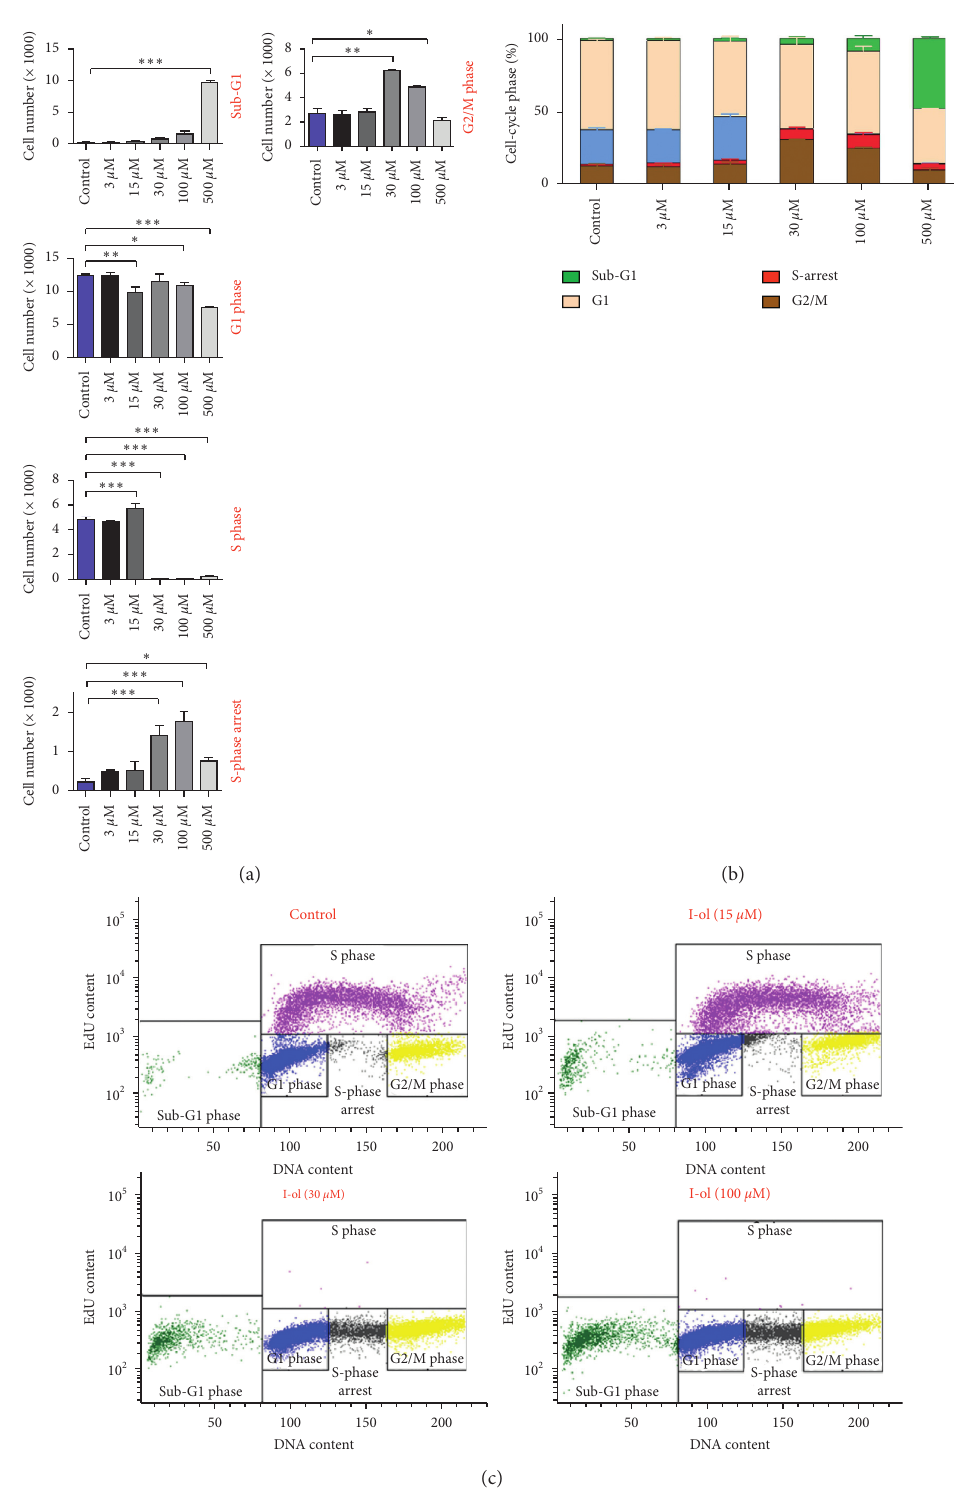
Figure 3: Regulation of cell-cycle progression. (a) Representation of each cell-cycle phase with increasing I-ol concentrations. A phase shift was observed at an I-ol concentration of 30 μ M. Specifically, we observed disappearance of cells in the S phase, a significant increase of S- phase arrest, and a large increase in the percentage of cells in G2/M phase and sub-G1 phase at the highest concentration. (b) Summary of the percentages of individual cells in each phase. (c) Representative scatter chart, where the y -axis represents the EdU-specific fluorescence on a logarithmic scale and the x -axis represents the cell cycle-specific fluorescence on a linear scale. The results after 48-hour incubation with I-ol are shown. After 72 or 96 h comparable results were obtained, those data are not shown to avoid redundancy. The results are shown as the mean ± SD. Statistical calculations were performed based on two-way mixed ANOVA, followed by Bonferroni’s post hoc test. In all cases, the significance levels were ∗ p < 0 . 05 (significant), ∗∗ p < 0 . 01 (highly significant), or ∗∗∗ p < 0 . 001 (very highly